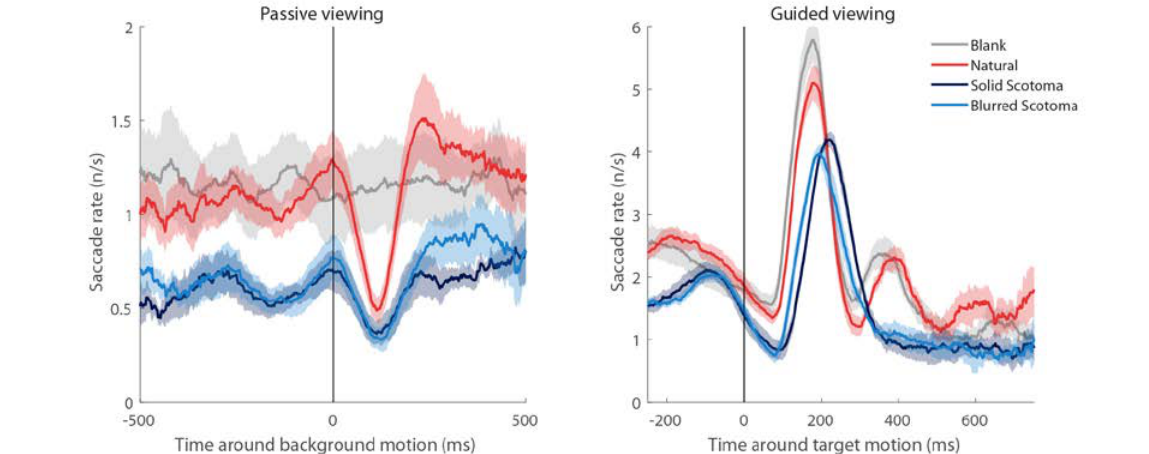
Figure 7. Correlation between image motion and (micro)saccade production in the passive-viewing and guided-viewing condi- tions. Each line indicates the average (micro)saccade rate across subjects relative to the occurrence of peripheral image motion (left panel) or fixation target motion (right panel). The lines where smoothed with a Savitzky-Golay filter of length 100 ms. Shaded areas represent the standard error of the mean across subjects